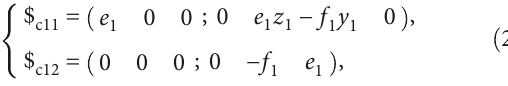
Figure 1: A fi ve-axis hybrid kinematic machine tool.